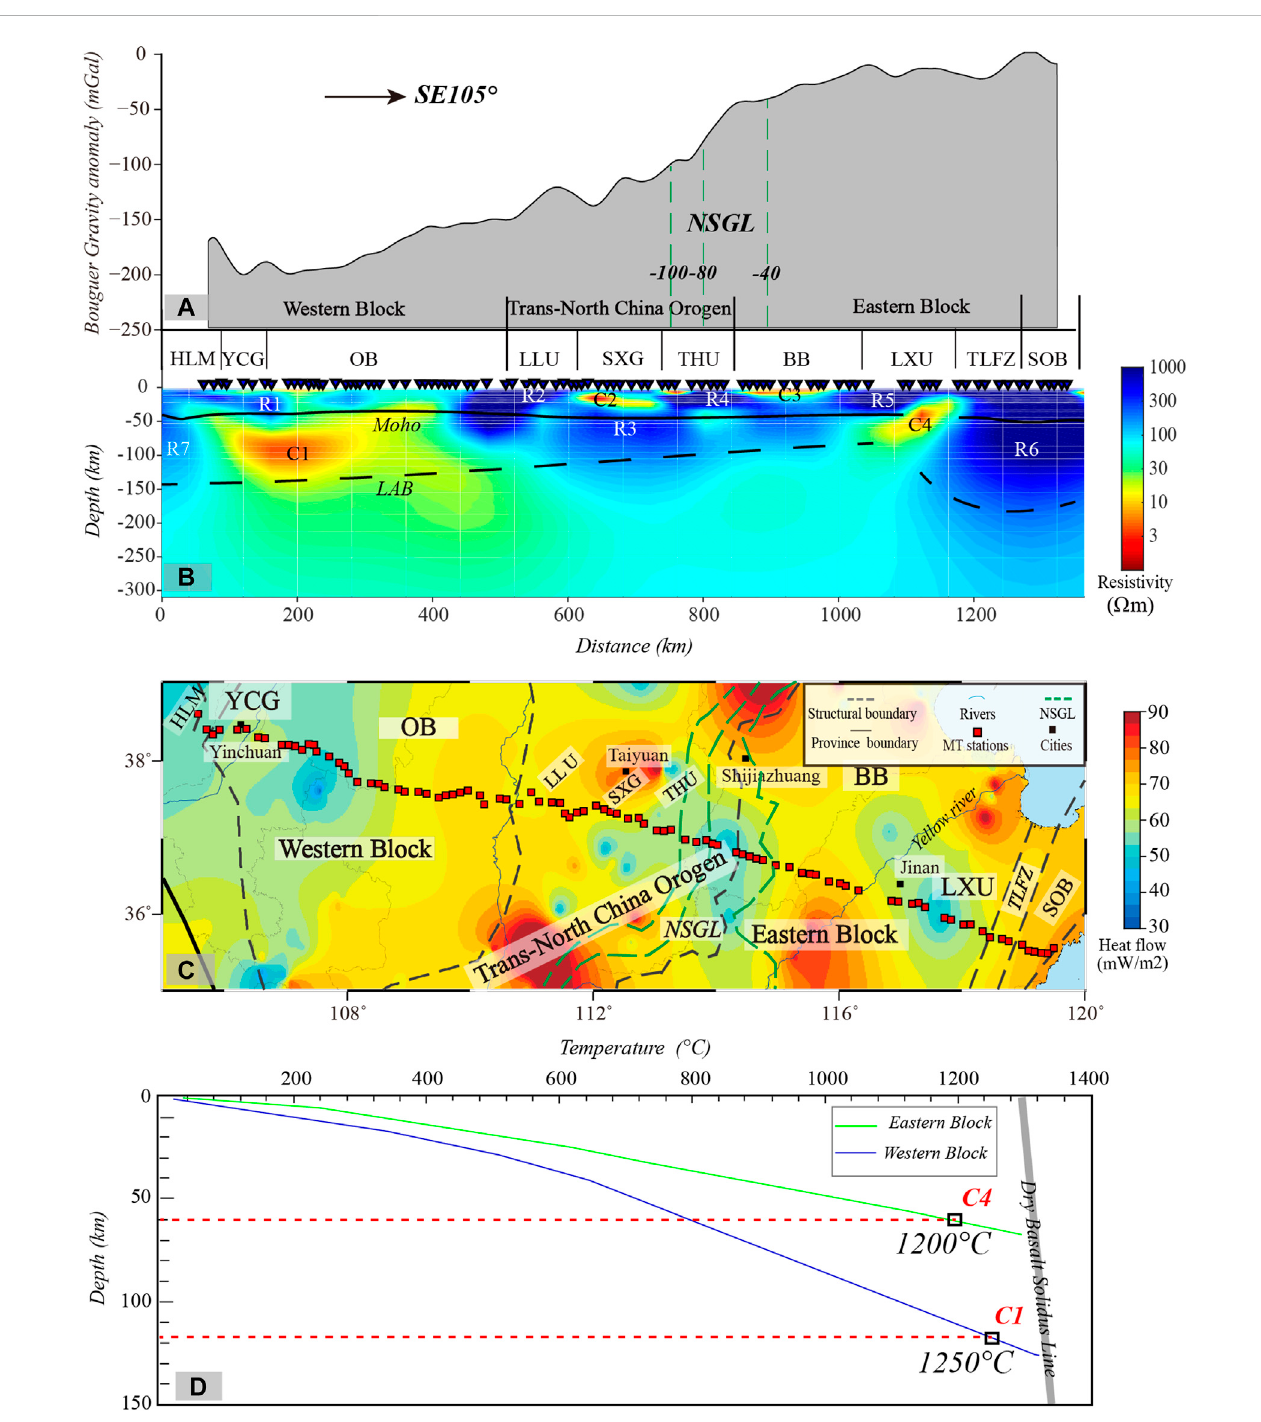
FIGURE 7 (A) TheBouguergravityanomalyalongtheARpro fi lebasedondatafromEGM2008after(Pavlisetal.,2012). (B) TheresistivitymodelalongtheARpro fi le cut from the 3D inversion model. The Moho and LAB is a combined result after (Deng et al., 2006; Chen, 2009; Chen, 2010; Li et al., 2011; Guo et al., 2012; Chen et al., 2014; Jia et al., 2014; Tian et al., 2014; Wu et al., 2014; Wang et al., 2015; Zhang et al., 2019; Cai et al., 2021). (C) Distribution of heat fl ow of the research area after (Jiang et al., 2019). (D) The temperature-depth curves of the Eastern and Western blocks of the North China Craton after [(Sun et al., 2013; Jiang et al., 2019; Qi et al., 2020). The dashed red lines represent the depths of the C1 and C4 conductors used to calculate melt fractions. The black squares represent the locations where the temperatures were adapted for the C1 and C4 conductors, respectively. HLM: Helan Mountain, YCG: Yinchuan Graben, OB: Ordos Block, LLU: Lüliang Uplift, SXG: Shanxi Graben, THU: Taihang Uplift, BB: Bohaiwan Basin, LXU: Luxi Uplift, SOB: Sulu Orogenic Belt, TLFZ: Tan-Lu Fault Zone, and NSGL: North-South Gravity lineament after (Deng et al.,